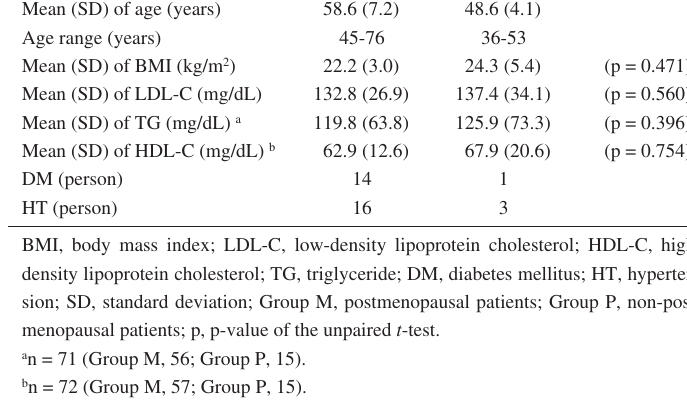
Table 4. Background characteristics of the two groups.